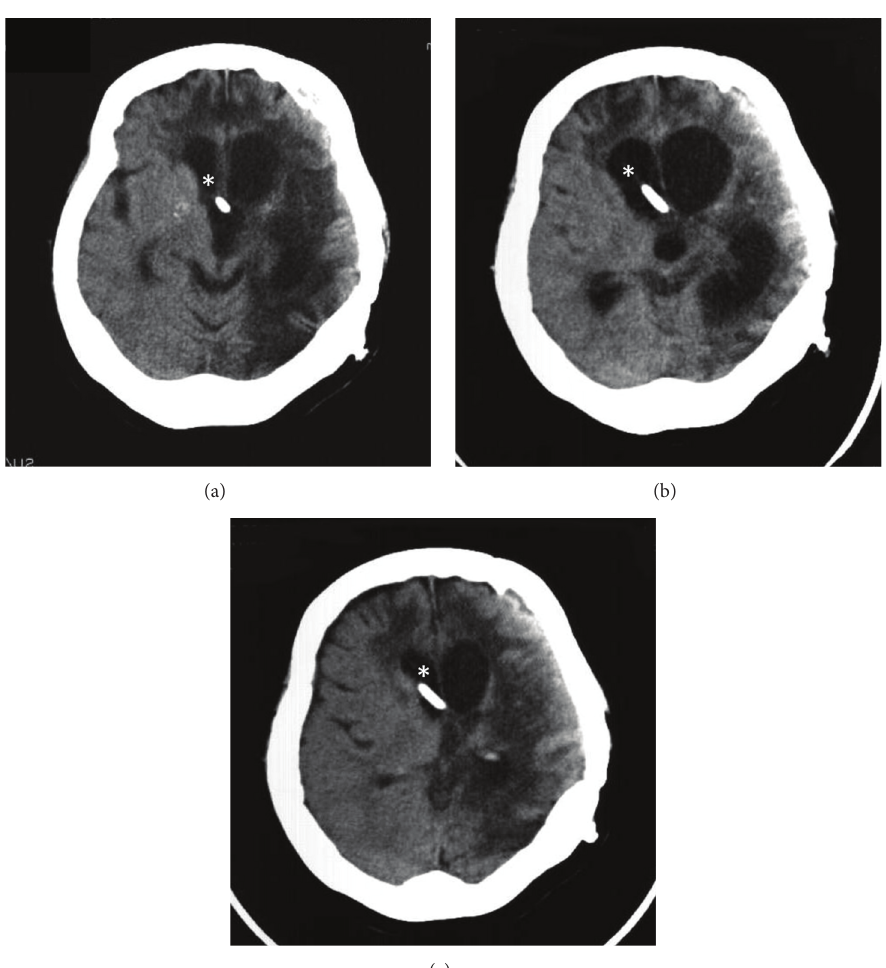
Figure 1: Head computer tomographic (CT) scan image that was performed at the time of admission (a) indicating previous destructive changes in the brain due to damage from the prior subarachnoid hemorrhage and vasospasms with mild hydrocephalus. Head CT scan image showing acute deterioration (b) indicating progression of the hydrocephalus. Head CT scan image after the ventriculoperitoneal (VP) shunt revision (c) showing improvement of the hydrocephalus. In each head CT scan image ((a), (b), or (c)), the VP shunt tube can be observed ( ∗